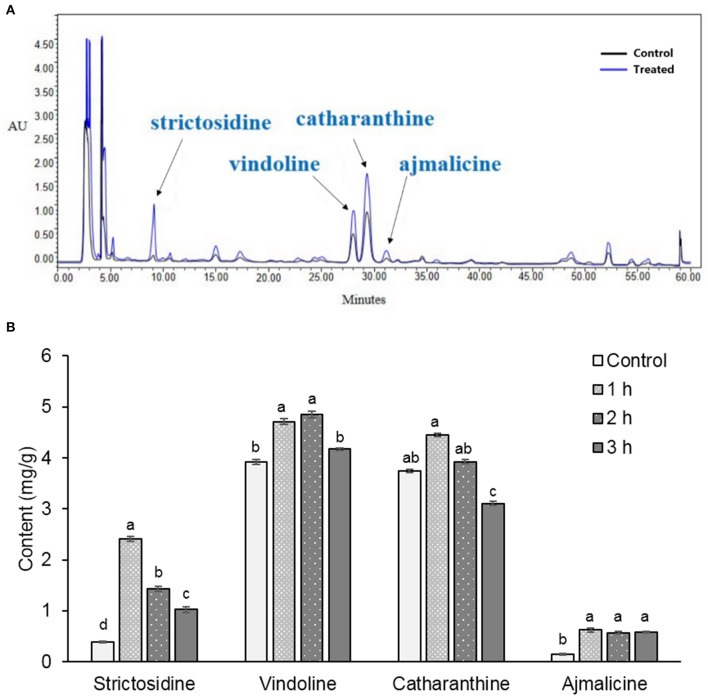
Pattern of metabolites in leaves of C. roseus. Methanol extracts from leaves collected from 45-day-old C. roseus plants were analyzed by HPLC (A). Arrowheads show the positions of the identified alkaloids. Control: C. roseus plants were only incubated for 72 h in the dark (black line). Treated: C. roseus plants were irradiated by UV-B for 1 h and incubated for 72 h in the dark (blue line). The content of the alkaloids in C. roseus under 1, 2, and 3 h UV-B irradiation times were calculated from standard curves (B). Data were shown as means ± SD from three independent biological replicates. Means with the same letter are not significantly different according to One-Way ANOVA test (p < 0.05). Control, plants with only 72 h of dark incubation.